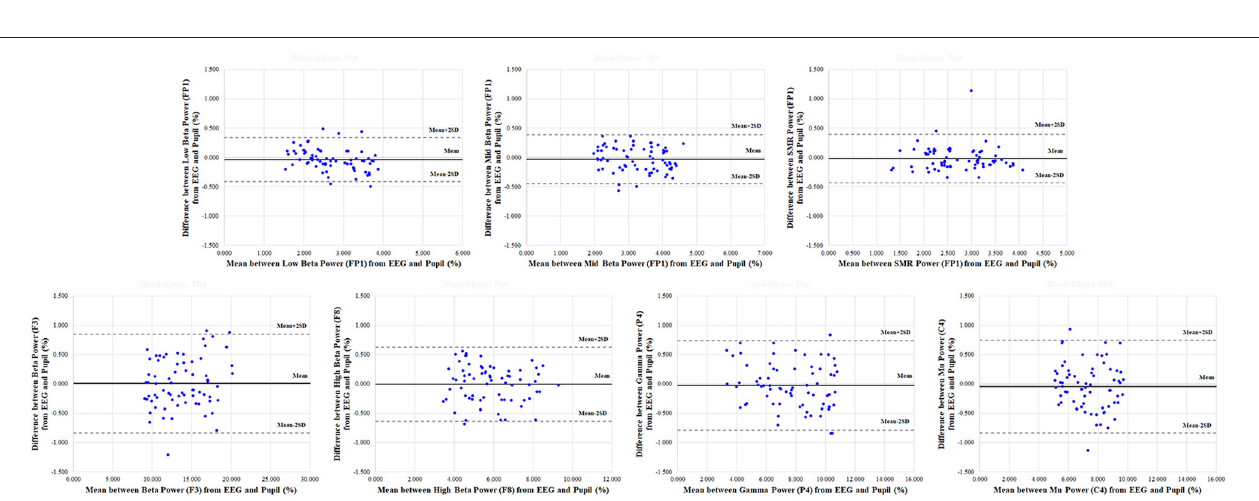
FIGURE 7 | Representative Bland-Altman plots in reference condition for electroencephalogram (EEG) spectral indexes (low beta in FP1; mid beta in FP1 region; SMR in FP1; beta in F3; high beta in F8; gamma in P4; mu in C4) between pupil and EEG signals. The centre solid line represents the mean difference between two measures, with the upper and lower dotted lines representing the 95% limits ( ± 2 SD) of agreement ( n = 70).